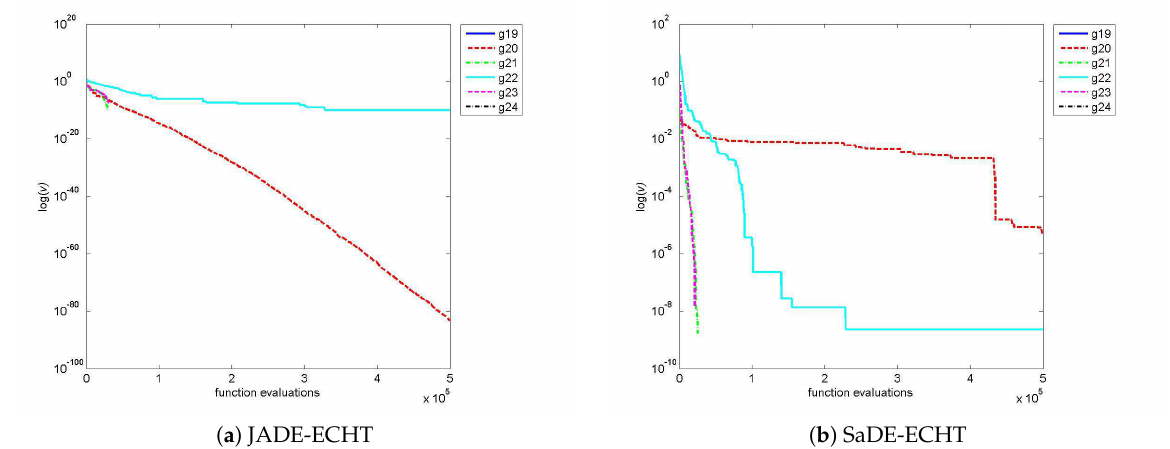
Figure 10. Constraint violation comparison of JADE-ECHT and SaDE-ECHT for